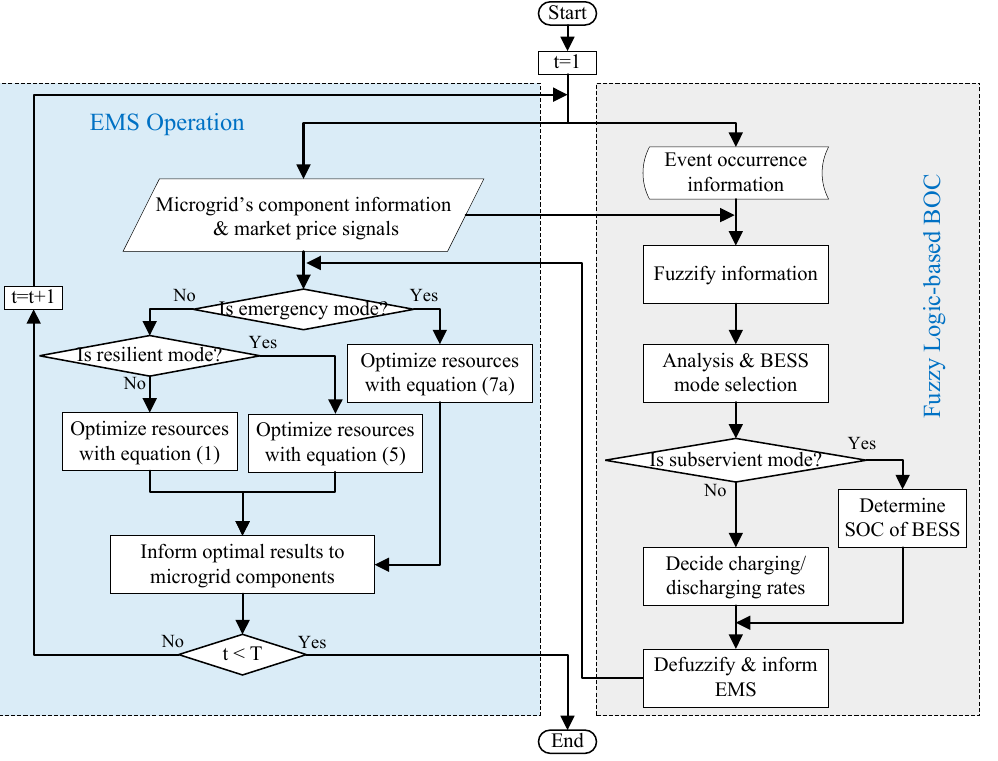
Figure 4. Flowchart for interaction between the EMS and the BESS operation controller.